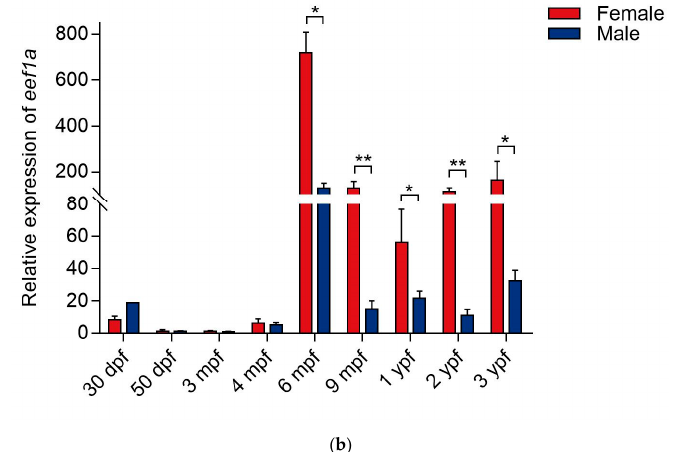
Figure 4. Expression pattern of eef1a1 in C. semilaevis : ( a ) Spatial distribution of eef1a1 in 3 ypf adult C. semilaevis maintained at normal temperature (22 °C). ( b ) Relative expression level of eef1a1 at different stages of the ovary and testis in C. semilaevis maintained at normal temperature. The expression levels were presented as mean ± S.E.M. ( n = 3). Asterisks represented statistically significant difference (*, p < 0.05; **, p < 0.01).